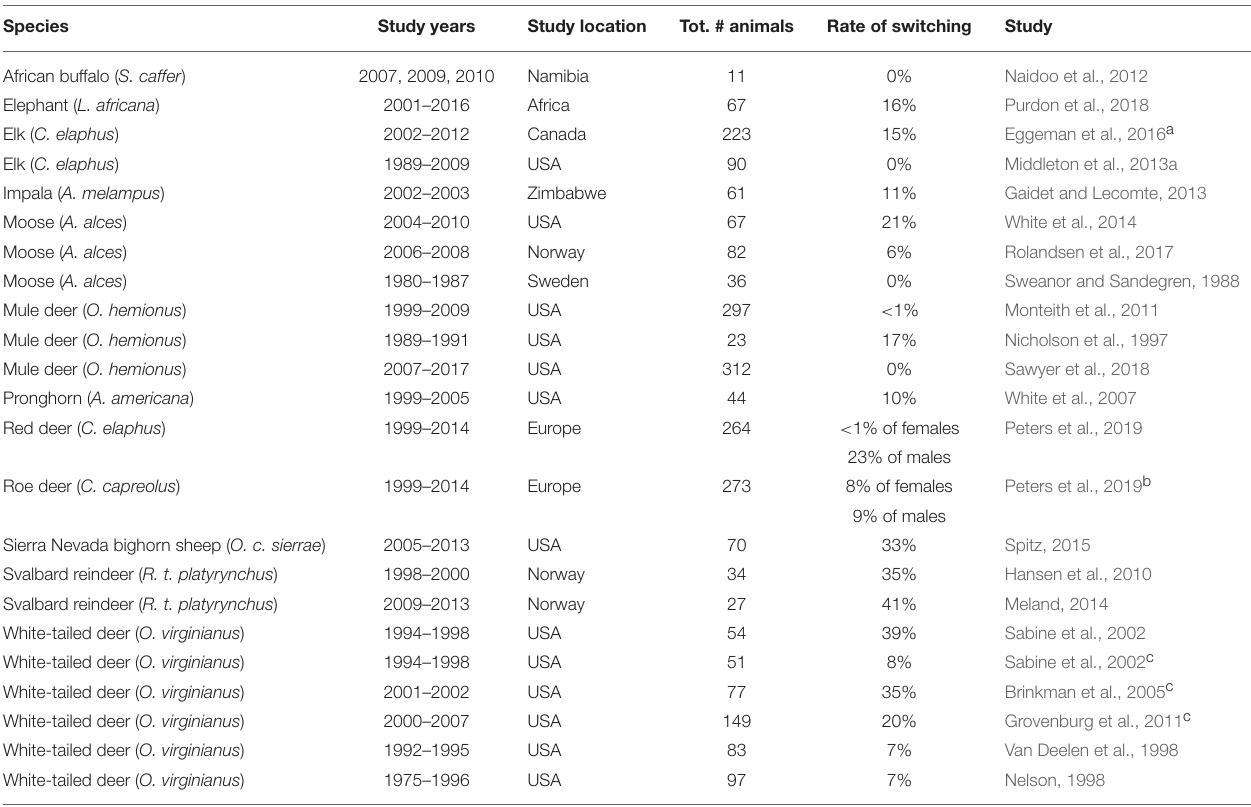
TABLE 3 | Reported rates of switching between migratory tactics in partially migratory populations of large ungulates. Species Study years Study location Tot. #